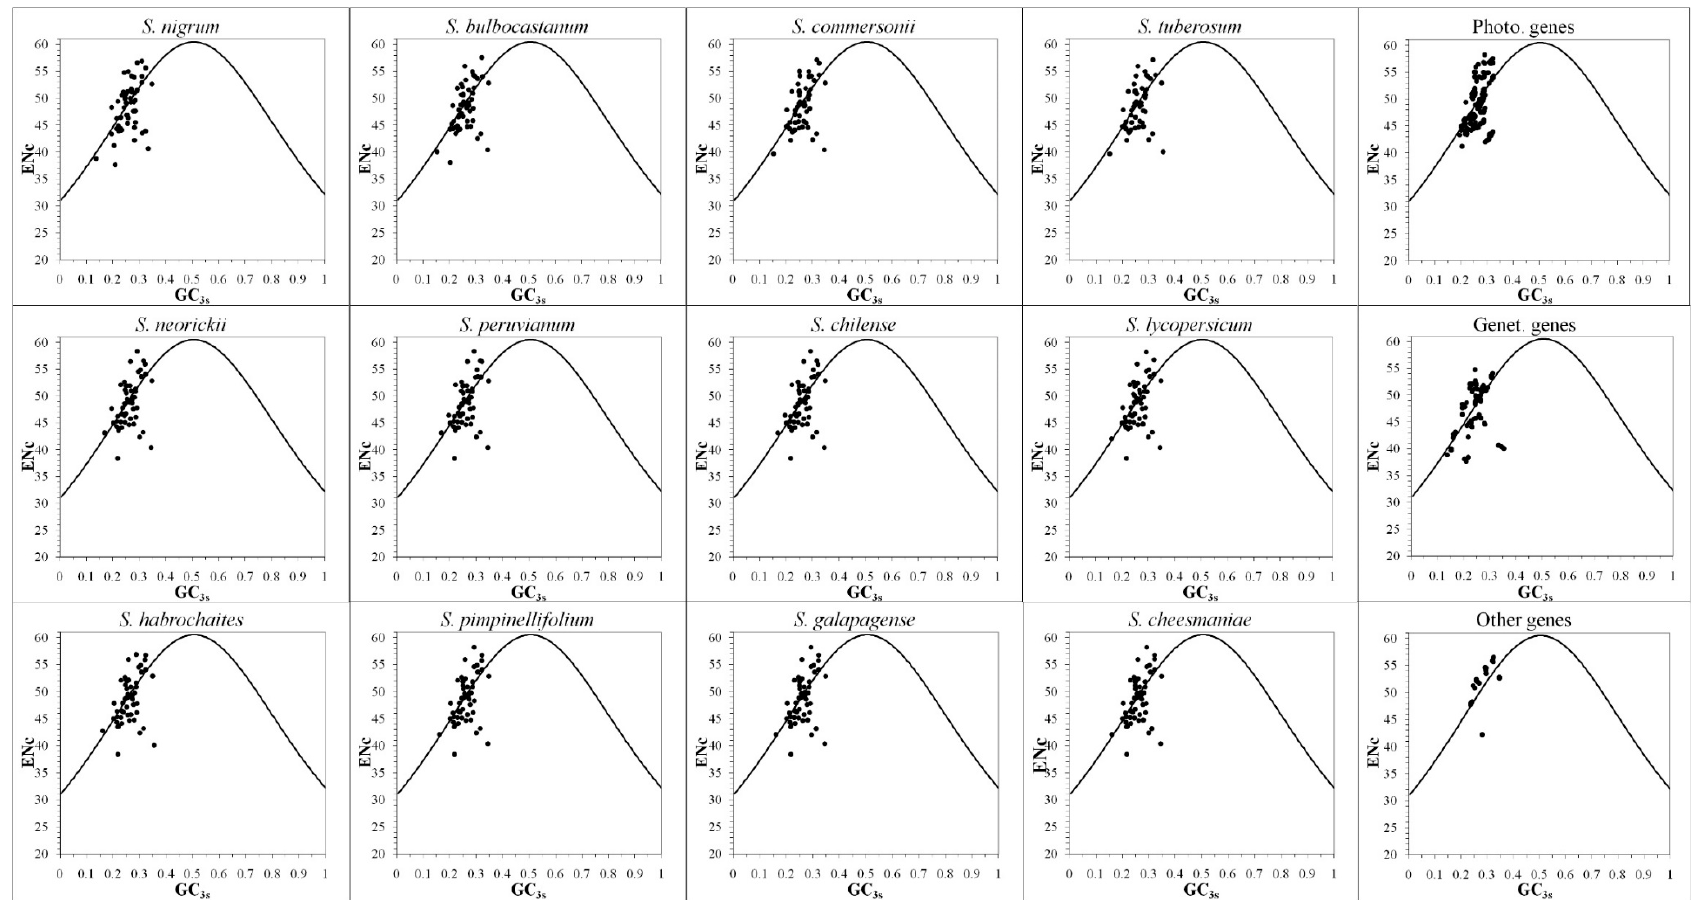
Figure 3. The ENc vs GC 3s plots of Solanum chloroplast genomes. The standard curve ENc = 2 + GC 3s + 29/[GC 3s2 + (1 − GC 3s ) 2 ] represents the expected ENc to GC 3s . The dots representing most Solanum chloroplast genes were far away from the curve, showing that their codon usage pattern was affected by other factors besides nucleotide composition.